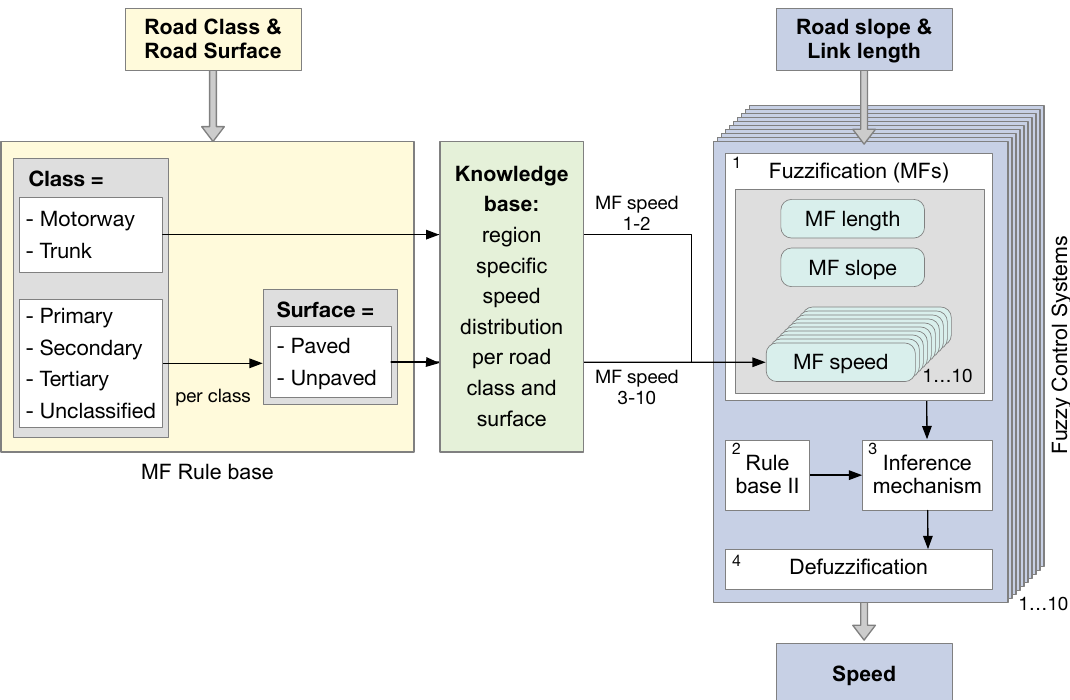
Figure 3. Schema of the Fuzzy Framework for Speed Estimation (Fuzzy-FSE) with four input parameters: road class, road surface, road slope and link length. Combined with the knowledge base, the membership function (MF) rule base forms ten different MFs for the output parameter